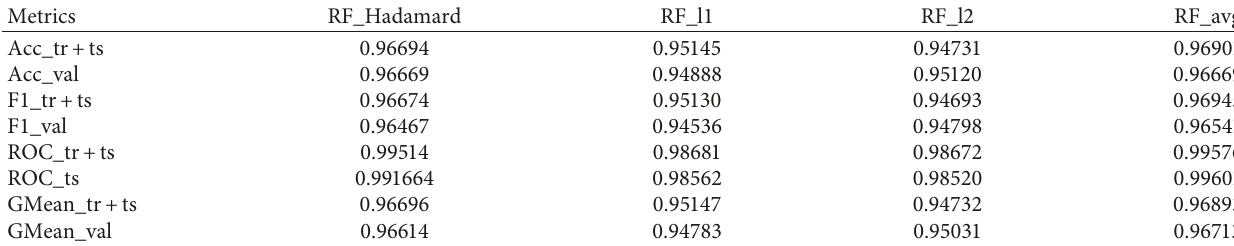
Table 10: For retweeting interaction from May 21 until May 26 in 2021, utilizing the obtained embeddings through Node2Vec, performance of the RF model with operators Hadamard, l1, l2, and average 1